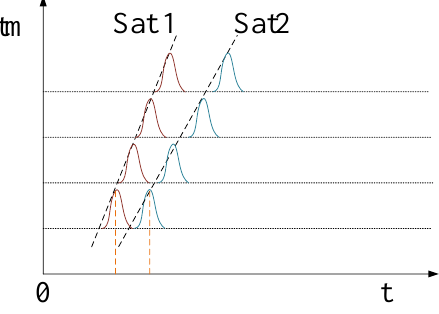
Figure 8. Amplitude migration of different satellites.